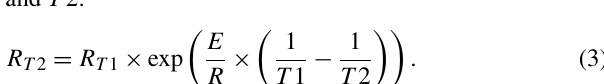
Figure 3. Photoproduction rates of NO with 0.5, 2, and 5.0µmolL − 1 NO − seawater (b) ; red symbols represent the artificial seawater samples, and black symbols represent the Milli-Q water